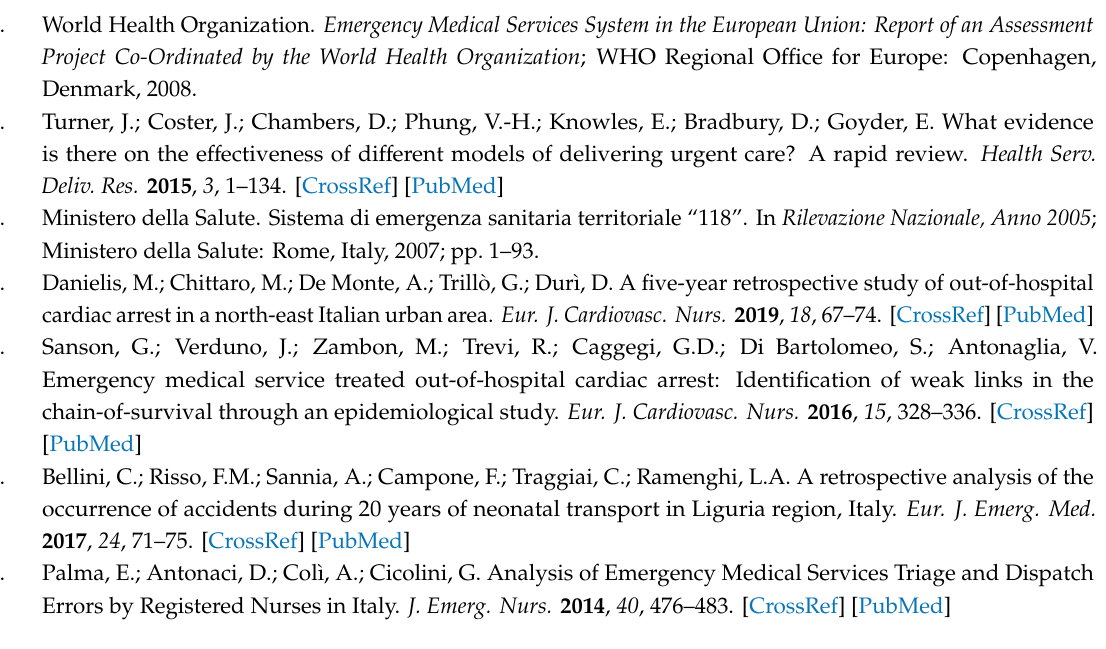
Table S1: Proportions (within year percentage) and 95% Confidence Interval (95%CI) of Emergency Medical Services (EMS) calls for which at least one rescue vehicle was dispatched, by year (2013–2017): within year proportions and 95% Confidence Interval; Table S2: Characteristics of Emergency Medical Services (EMS) rescue vehicle dispatches by year (2013–2017) among 1,658,728 total rescue vehicles dispatched. Table S3: Emergency Medical Services (EMS) criticality codes* by type of rescue vehicle dispatched and rescue completion (RC) at a hospital emergency department (HED); percentage of rescues completed at HED. Total emergency medical vehicles (EMV) dispatched: 1,658,728, with 1,239,760 RC at HED;